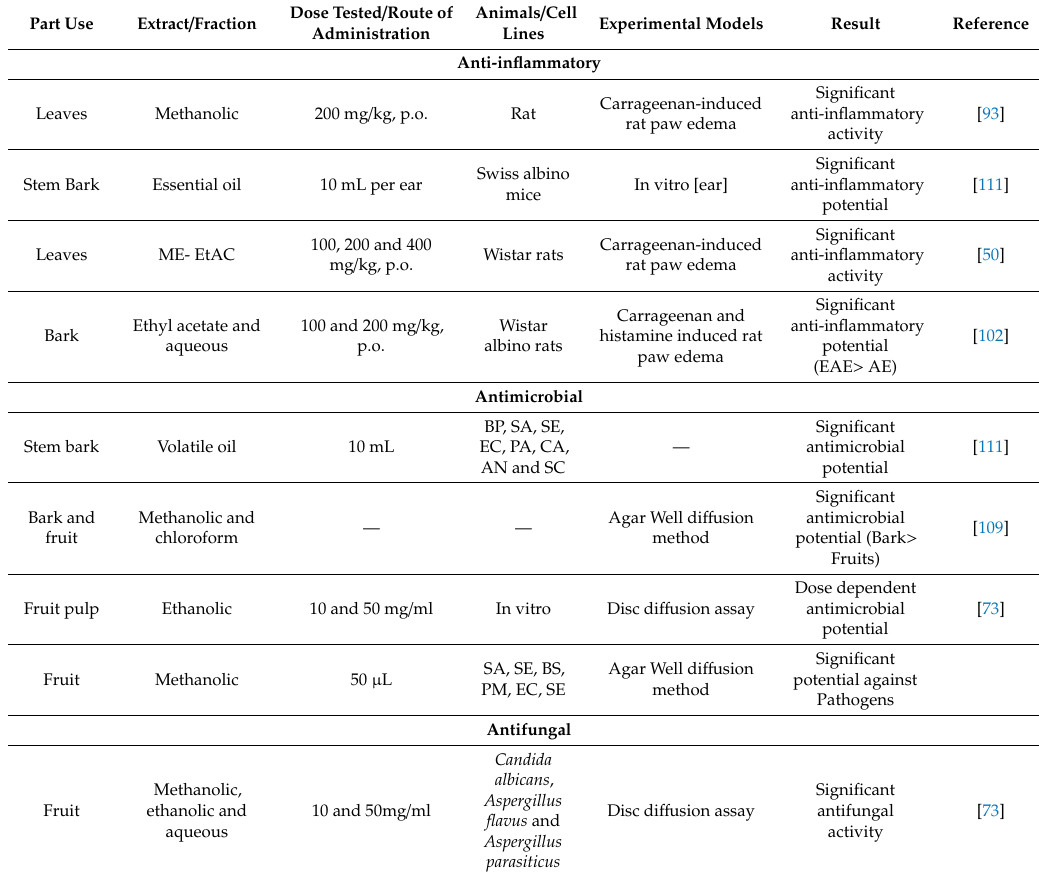
Table 6. Biological e ff ects of M.